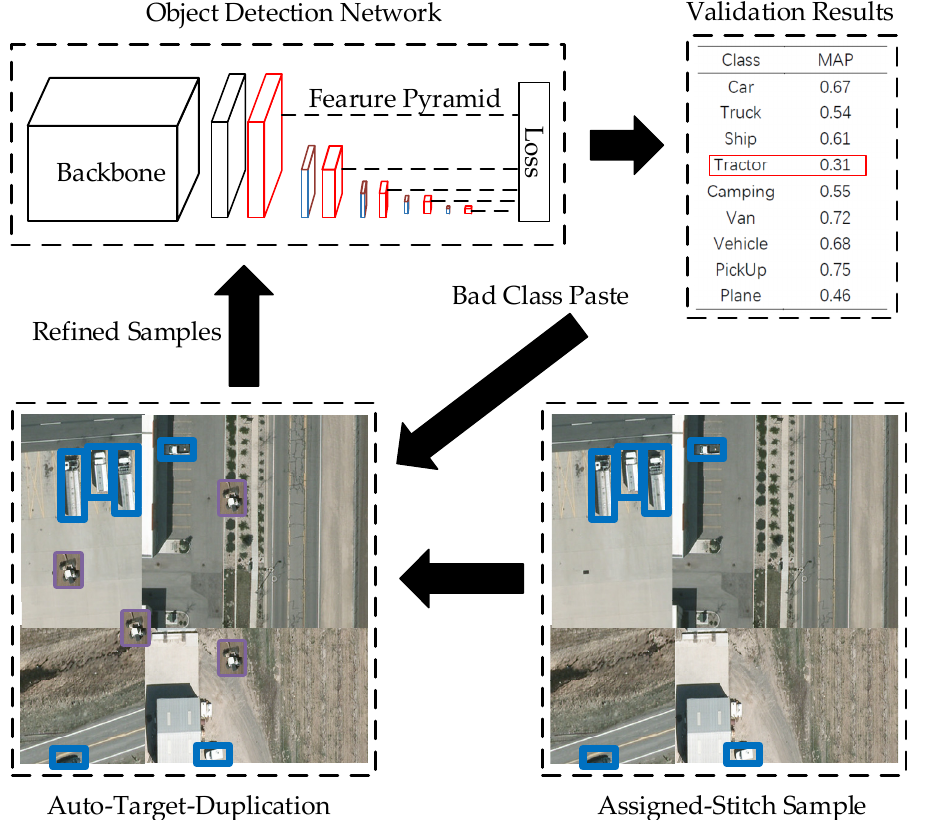
Algorithm 2 details the Auto-Target-Duplication procedure.